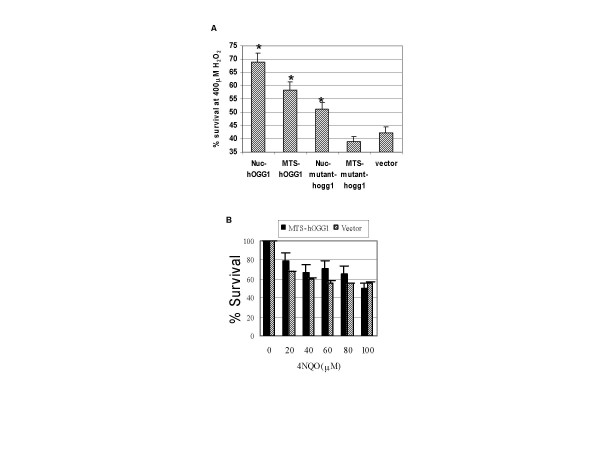
Cell Survival of hOGG1 Regulated Cells. HeLa cells transfected with indicated plasmids were grown in regular growth media, for 72 h post transfection. The cells were plated at a density such that they reached a 70% confluence on the day of the treatment. The cells were then treated with 400 μM H2O2 (A) for 2 h and for 1 h with 4NQO (B) in serum free media, and allowed to recover in normal growth medium for 16 h. Cellular survival was assessed using the MTT cell proliferation assay kit. Error bars represent standard deviation of four points. Nuc-hOGG1 (nuclear targeted hOGG1); MTS-hOGG1 (mitochondrially-targeted hOGG1), Nuc-mutant-hogg1 (nuclear targeted mutant hogg1), MTS-mutant-hogg1 (mitochondrially-targeted mutant hogg1), Vector (empty vector). p < 0.05 when the data from Nuc-hOGG1, MTS-hOGG1 and Nuc-Mutant-hogg1 transfectants was compared with vector-only cells using Student's t test.